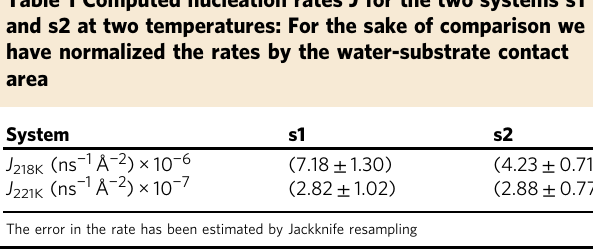
Table 1 Computed nucleation rates J for the two systems